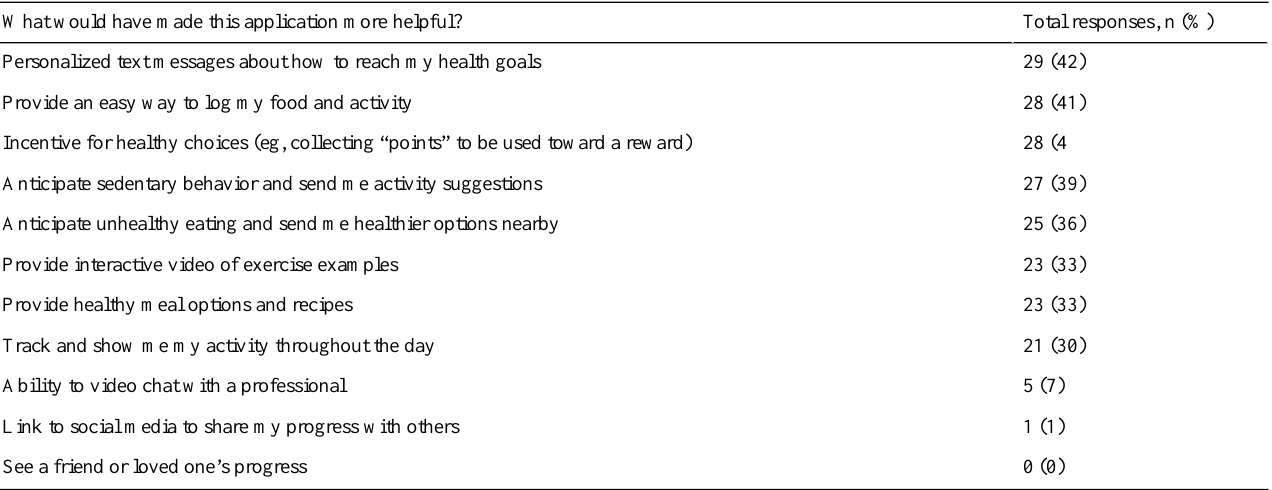
Table 2. Pooled data for all participants (n=19, total possible responses n=69) responding to acceptability, feasibility, and appropriateness questions deployed at the end of each day.